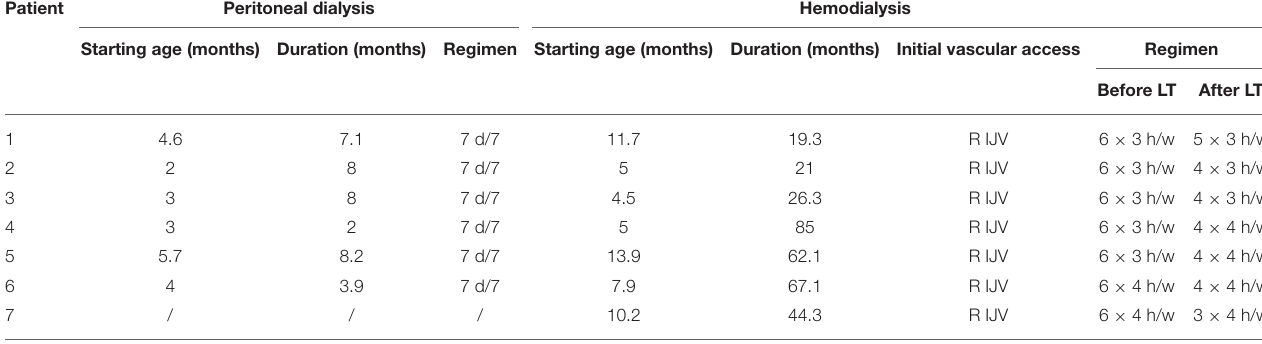
TABLE 2 | Renal replacement